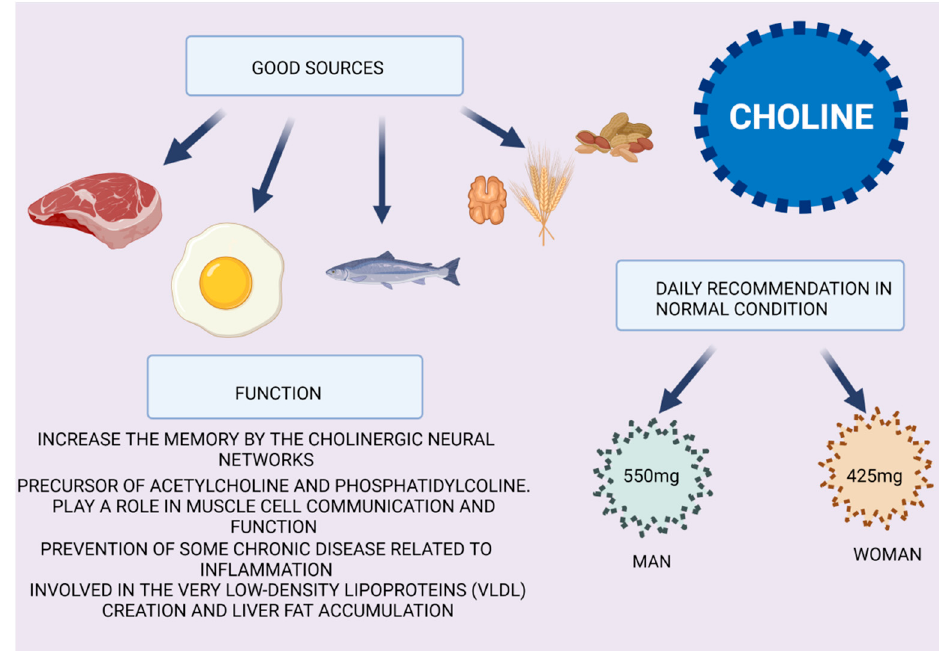
Figure 5. Choline properties. A variety of foods contain choline, with meat, fish, nuts, dairy products and eggs providing the richest sources. For adult men and women aged 19 years old or older, the adequate intake is 550 mg and 425 mg, respectively. Here, the principal functions of choline in cell metabolism and wellness are described.